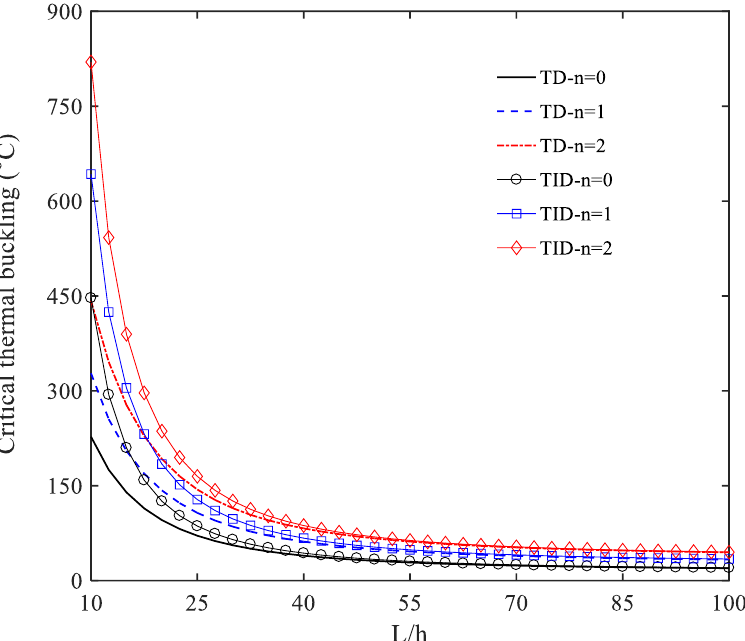
Figure 5. Variation of the critical thermal loading vs. L / h for TD and TID properties, and different values of n ( V SMA = 0.2, ε 0 = 2%, h c / h = 0.8 ).